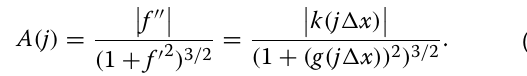
x- axis coincides with the leveling direction of the plate, as shown in Figure 2. The curvature is considered posi- tive when the curve is concave. Correspondingly, the cur- vature is negative when the curve is convex. In a similar manner, the moment making the plate bend in a concave fashion is defined as positive and the moment responsi- ble for the convex bending of the plate as negative. R is the roller radius. As the plate is replaced by its neutral layer, the roller radius r used in the calculation is the sum of the actual roller radius and half thickness of the plate. L i is the half length of the roller space, l i ′ is the distance between adjacent contact points along the leveling direc- tion, t i is the inter-mesh of two adjacent rollers, and t i ′ is the distance between two adjacent contact points along the plate thickness direction. When the contact point of roller i is above the contact point of roller i 1, t i and t i ′ + are positive. When the contact point of roller i is below the contact point of roller i 1, t i and t i ′ are negative. θ i + is the contact angle of roller i with the plate and it is an acute angle. θ i is positive when it is located in the positive half of the z- axis. Otherwise, θ i is negative.